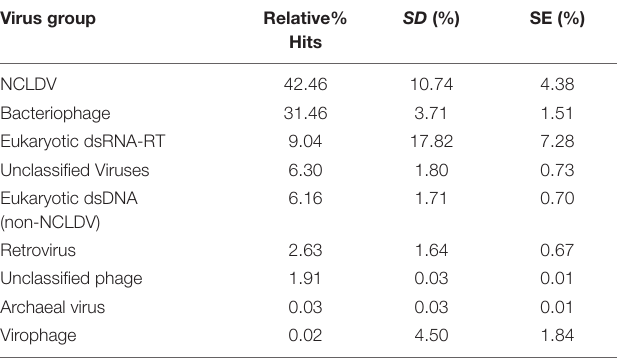
TABLE 2 | Viral contig similarities (noted as “hits”) to viral